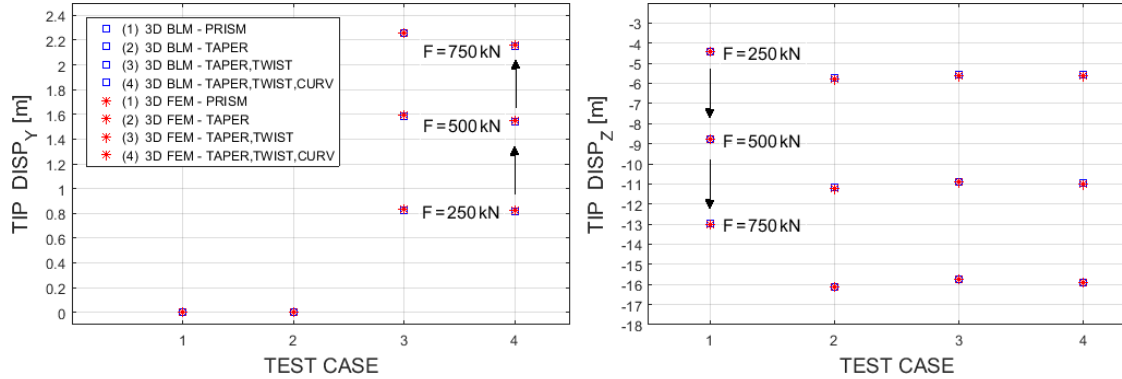
Figure 12. Tip displacements with 3D BLM (blue) and 3D FEM (red) for different geometries and increasing F (see